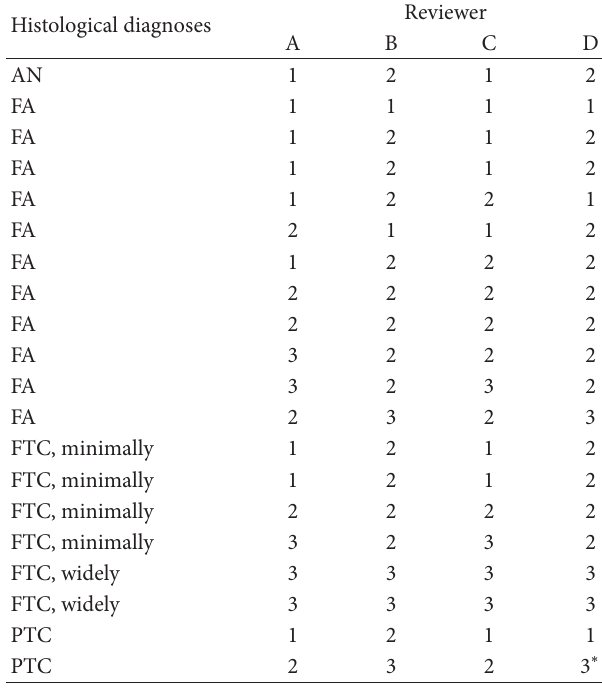
Table 1: Cytological reporting system recommended by the Japan Thyroid Association guidelines for clinical practice on the manage- ment of thyroid nodules, 2013.